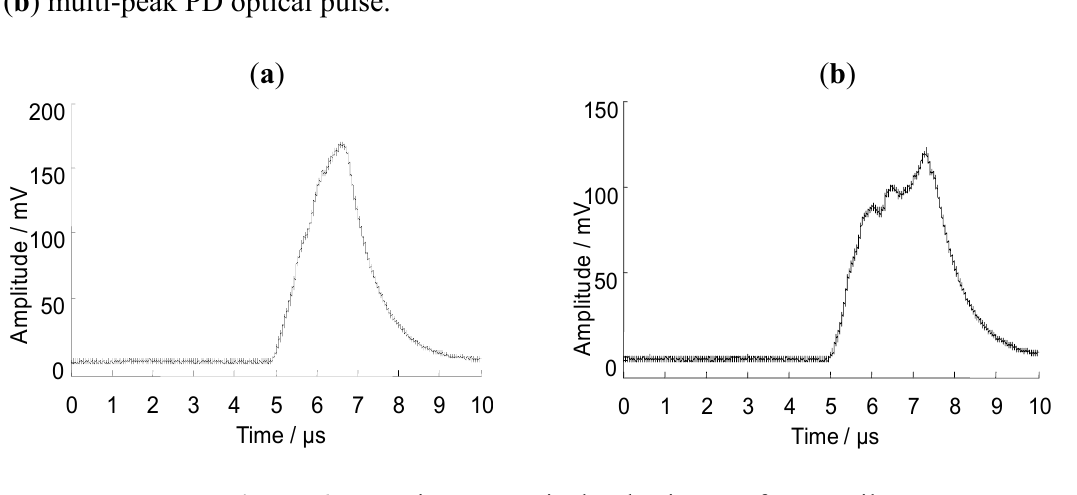
Figure 6. Negative PD optical pulse in transformer